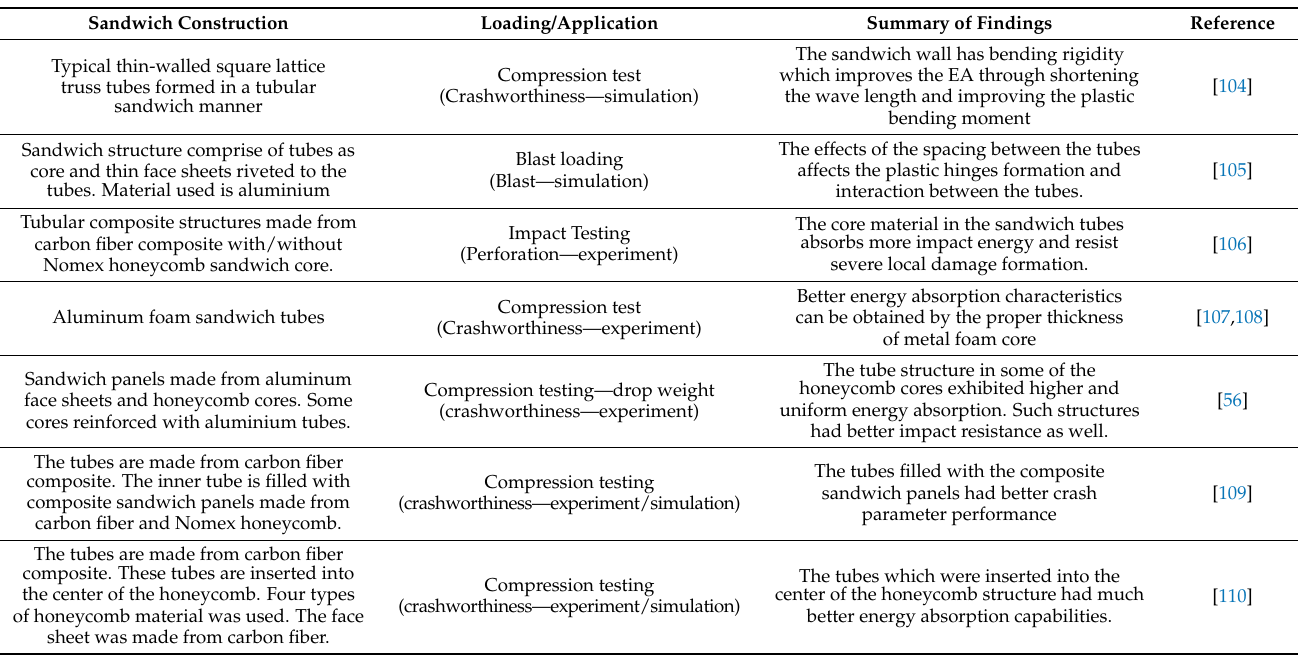
Table 7. Sandwich structure with tubular core.